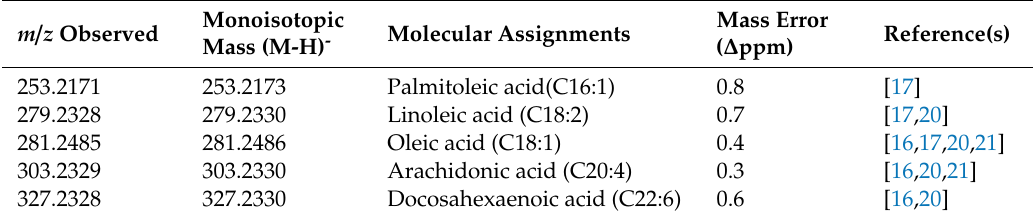
Table 2. List of assigned peaks in the spectra of the human lip obtained by DESI–MSI in negative ion mode.